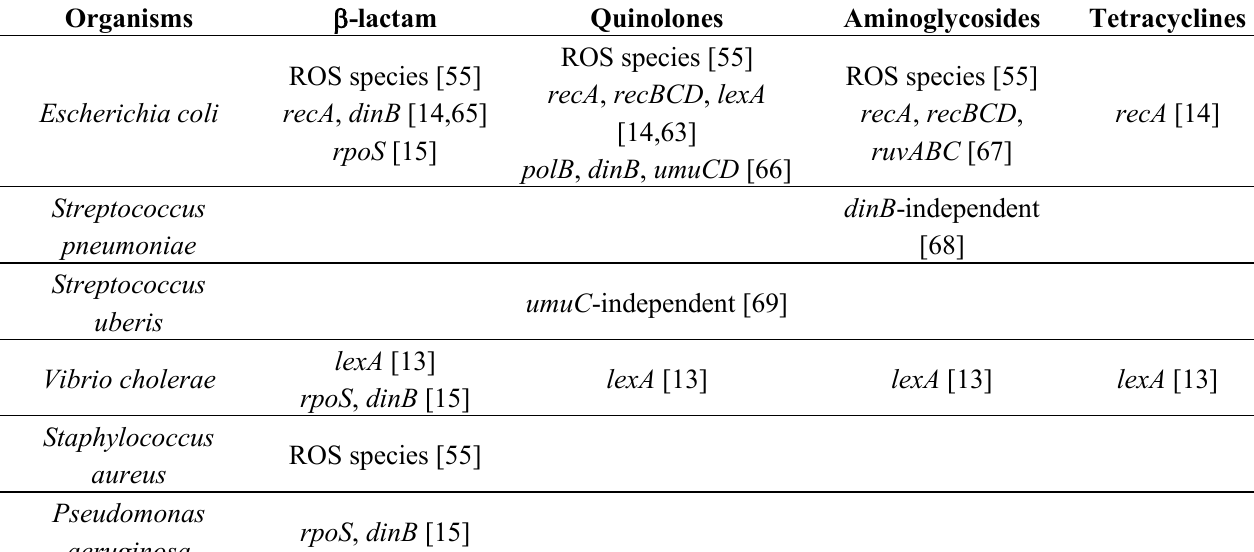
Table 1. Molecular mechanisms involved in antibiotic-induced mutagenesis in different bacterial species.